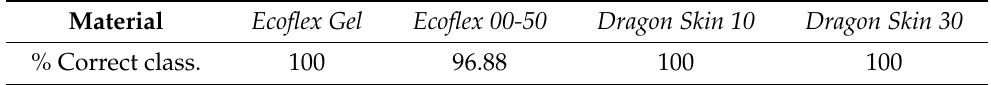
Table 4. Percentage of correct classifications when considering ˆ k nl as the BC input. Material Ecoflex Gel Ecoflex 00-50 Dragon Skin 10 Dragon Skin 30 % Correct class.